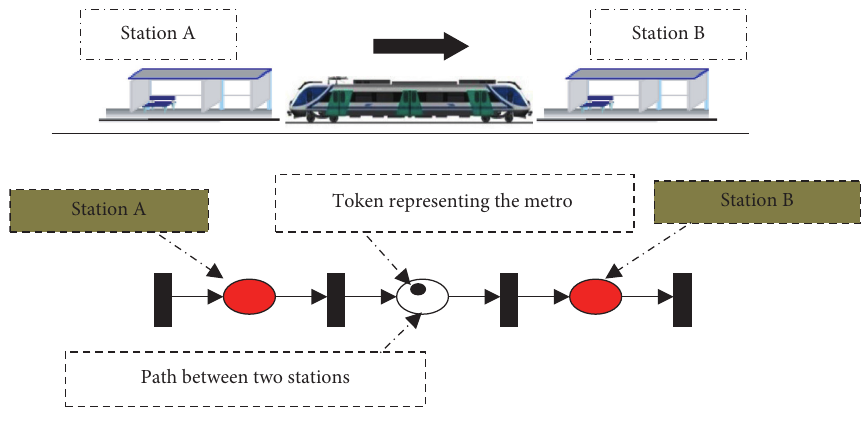
Figure 4: Model of a single directional segment.